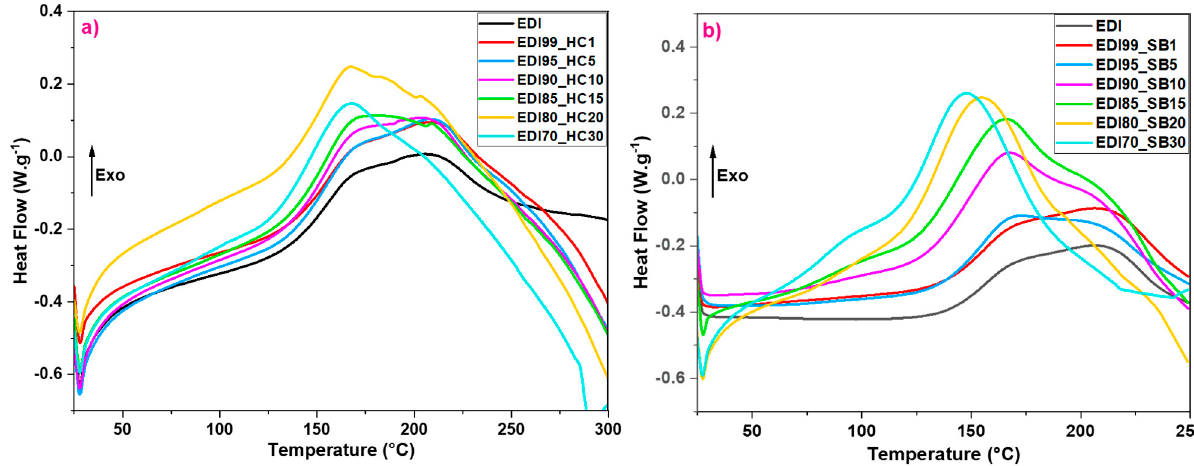
Figure 1. DSC thermograms during dynamic heating at 10 ◦ C · min − 1 of the epoxy-based formulation with ( a ) HC and ( b ) SB filler. Table 1. DSC data obtained for the DSC curing of epoxy formulations with HC and SB. Sample